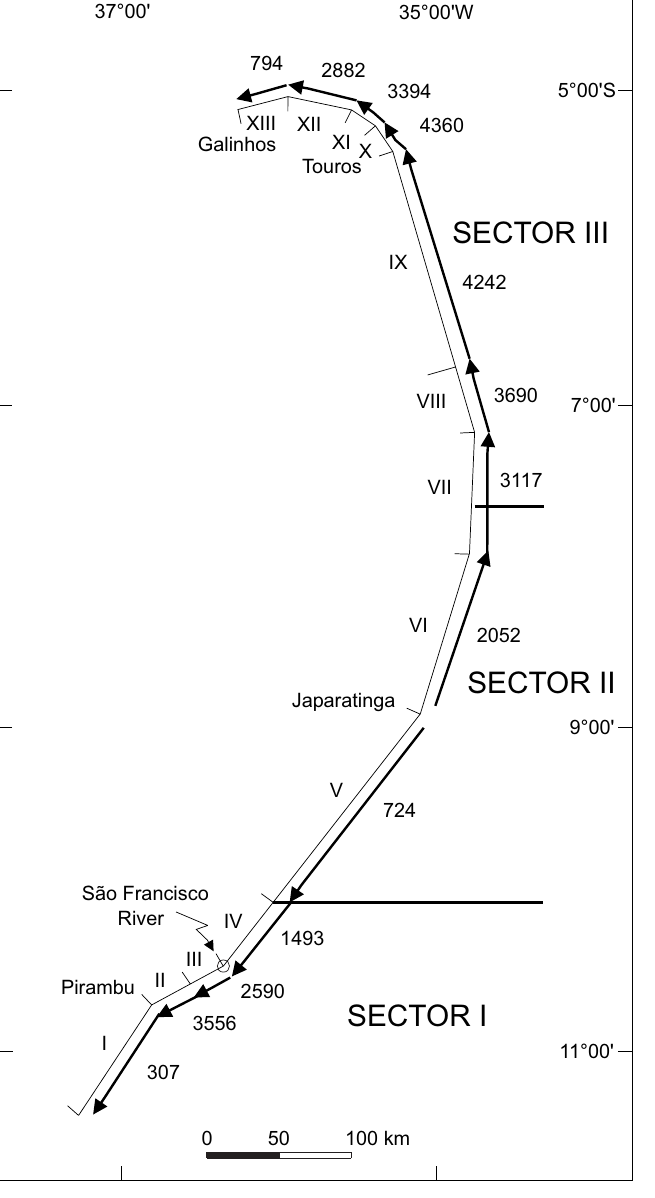
Fig. 6 – Directions of the net longshore drift computed in the present work for each rectilinearized segment. The numbers at the arrow side are the potential intensity of the net longshore drift (See Table